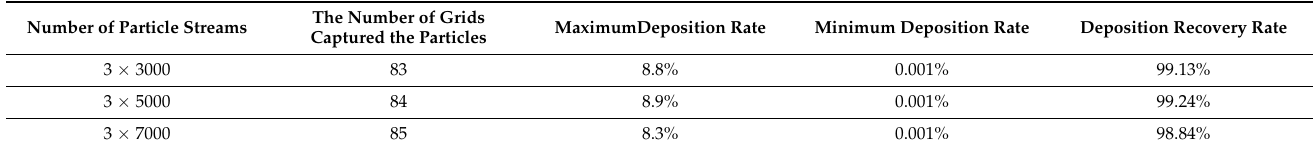
Table 4. Droplet deposition at different number of particle streams.